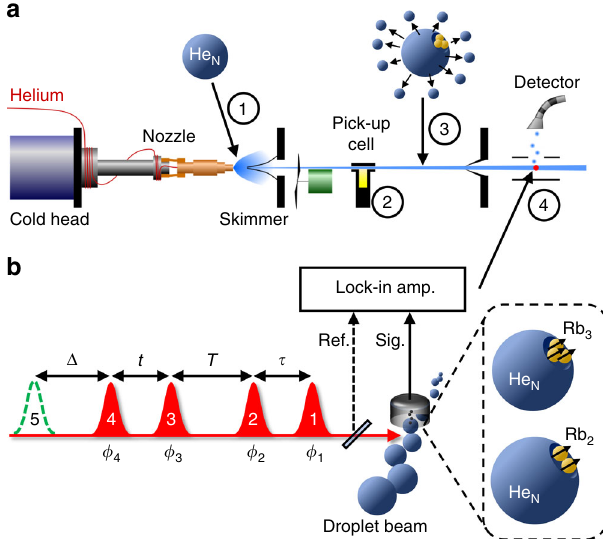
Fig. 1 Experimental scheme. a Molecular beam-type vacuum apparatus for helium nanodroplet beam generation upon adiabatic expansion of helium (1), followed by doping with Rb atoms in a pick-up cell (2) and evaporative cooling of the formed Rb molecules (3). The isolated, cold Rb 2 and Rb 3 molecules intersect with the laser beam and photoelectrons/-ions are detected (4). b Four phase-modulated laser pulses with delays τ , T and t , excite and ionize the prepared molecules in the droplet beam. The phase ϕ i of each pulse is individually modulated at kHz-frequencies, leading to a modulation-beat of the photoelectron/-ion yield. A lock-in ampli fi er is used for demodulation and isolation of the nonlinear 2D signal components. For a more selective ionization, a fi fth pulse delayed by Δ is optionally In this scheme, four phase-modulated laser pulses induce a mapped onto the photoionization yield (Supplementary Fig. 3).